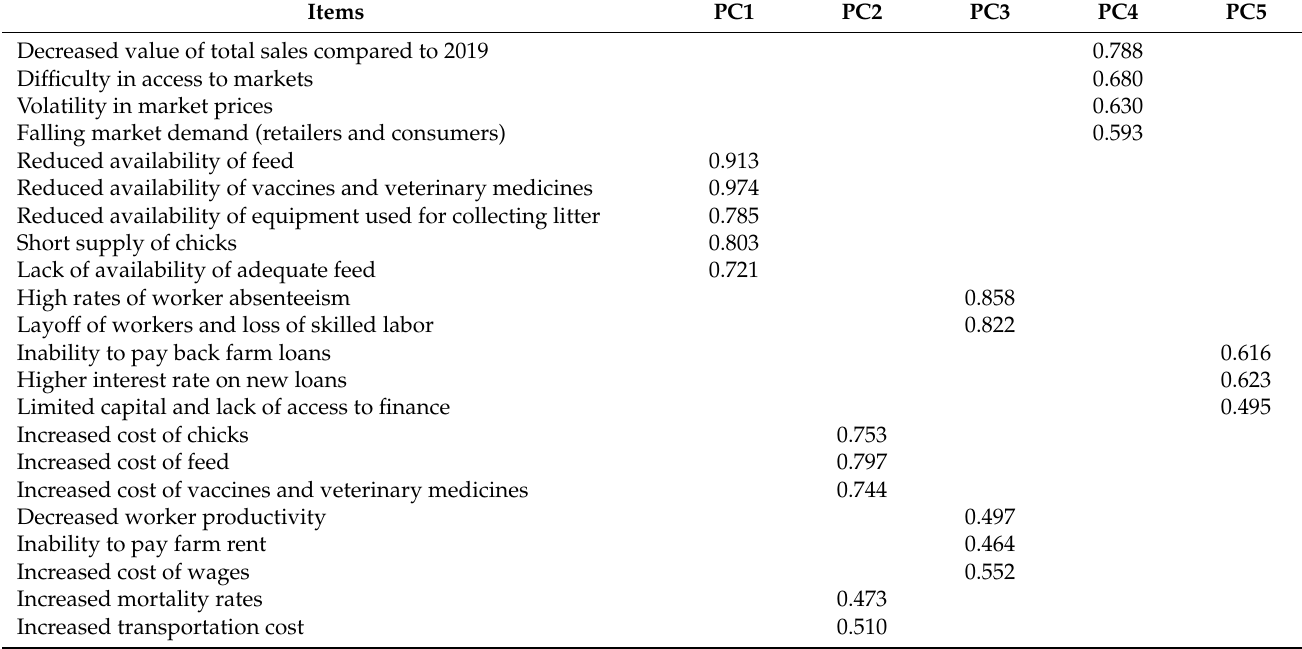
Table 4. Polychoric PCA for the main impact pathways of the pandemic on the farms surveyed. Items PC1 PC2 PC3 PC4 PC5